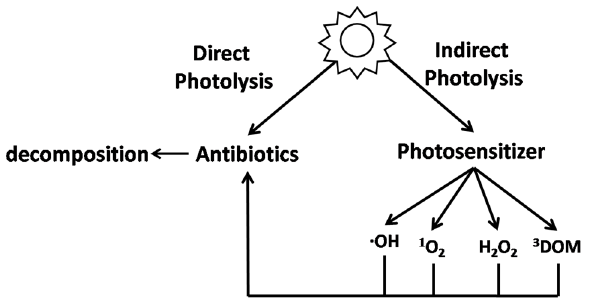
Figure 1. Comparison of direct and indirect photolysis (DOM: dissolved organic matter). Reproduced with permission from Arnold and McNeill, Analysis, Fate and Removal of Pharmaceuticals in the Water Cycle [53]; published by Elsevier, 2007.